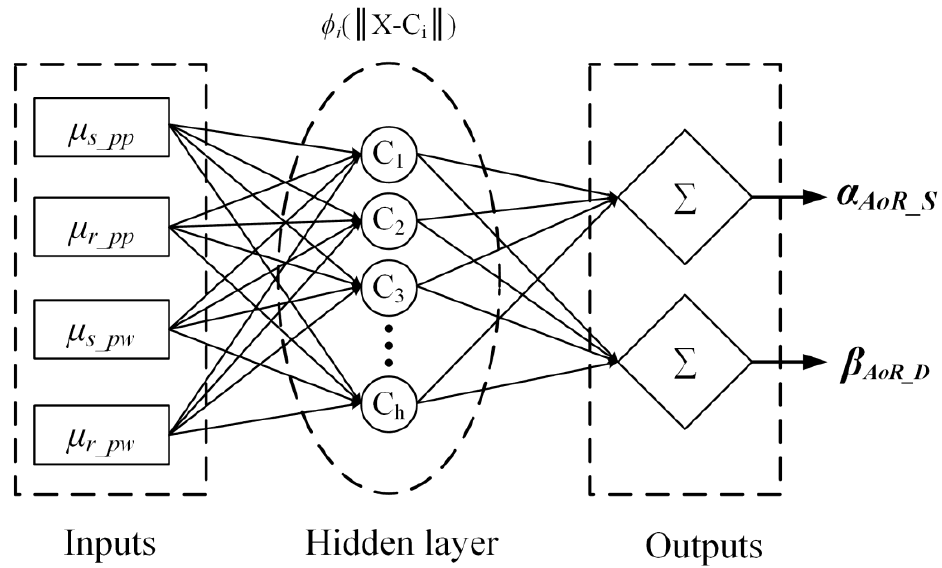
Figure 10. RBF neural network topology.